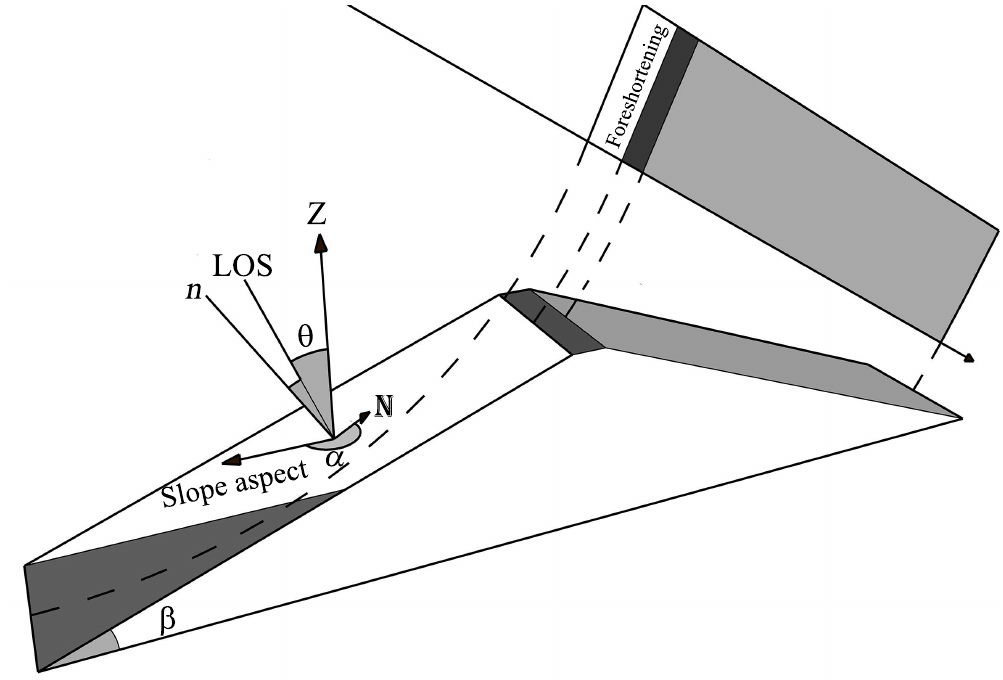
Figure 2. The foreshortening effect on the slopes of embankment dams. Plotted after Cigna et al [59]. Table 1. Foreshortening compression factors over the upstream (UPS) and downstream (DNS) slopes of the Darbandikhan dam for both ascending (As) and descending (Ds) tracks. Note that (i) the average incidence angle for the dam area is provided for each track; (ii) the downslope of the dam ( β ) is 30 ◦ , and the aspect ( α ) is 220 ◦ for downstream and 40 ◦ for the upstream slopes. LOS: line of sight. Track No. Flight